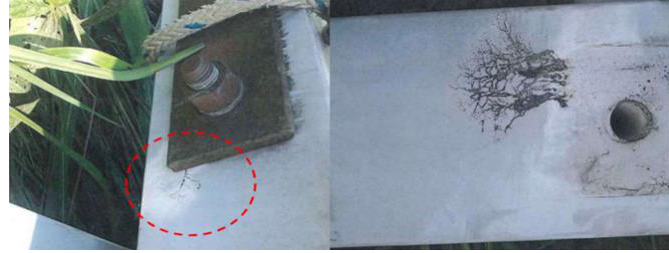
Figure 1. Typical surface tracking on a composite crossarm [2].